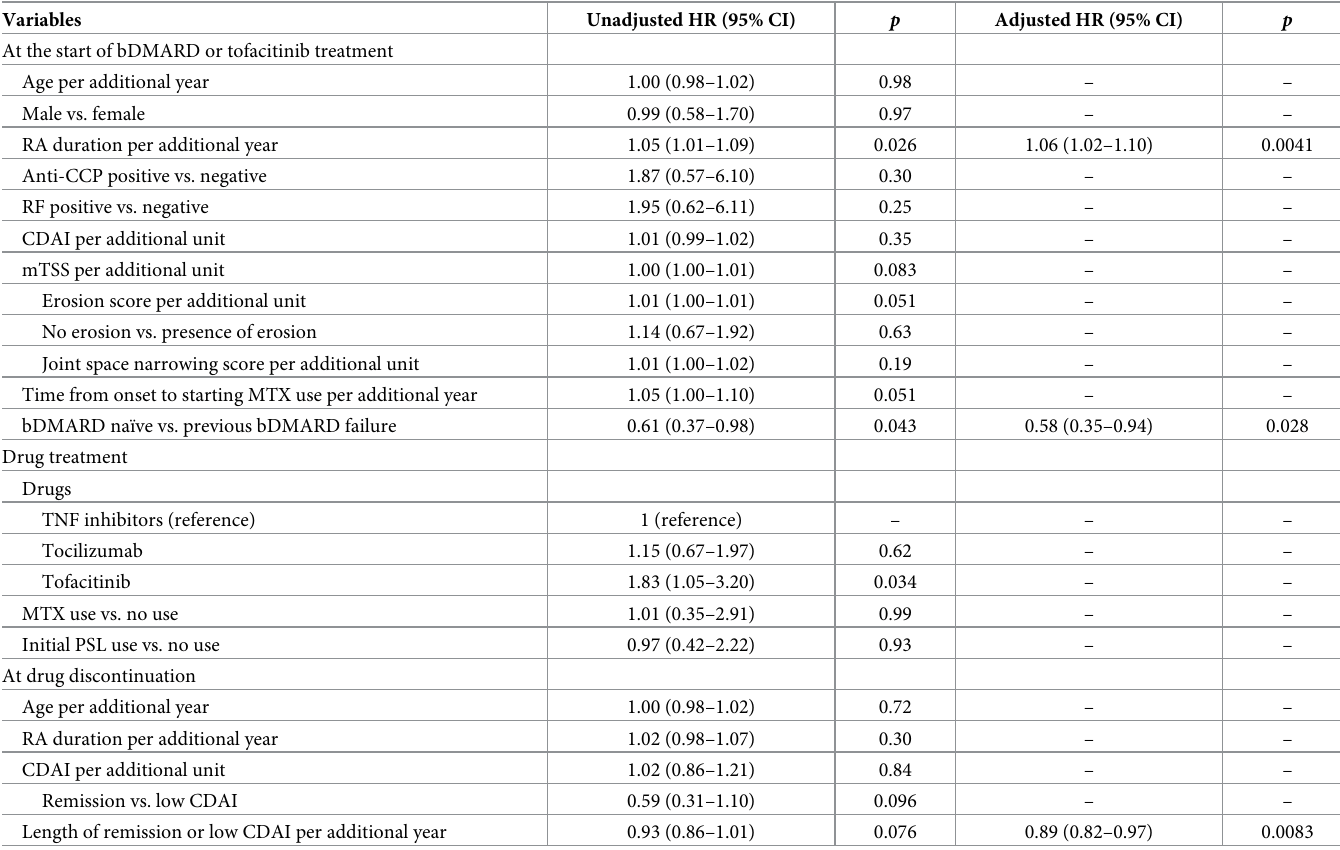
Table 3. Univariable and multivariable Fine–Gray regression analyses for disease flare after drug